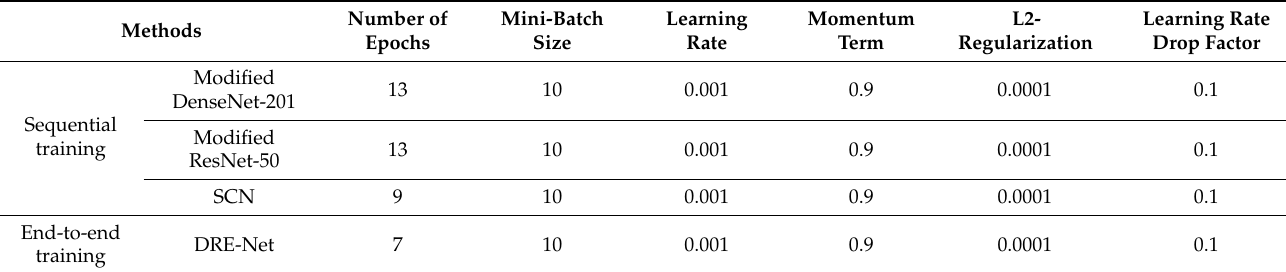
Table 6. Parameters for network